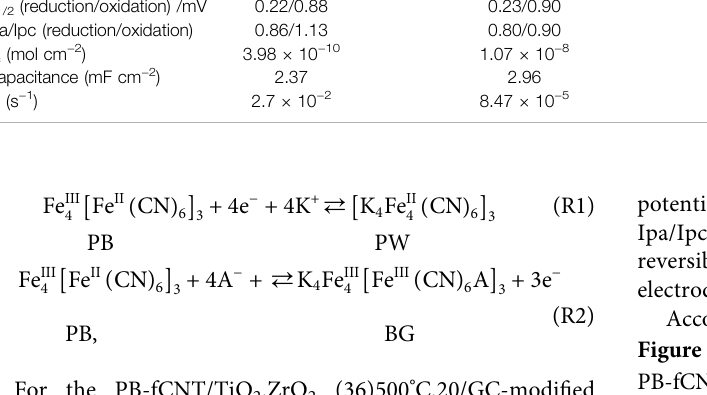
TABLE 4 | Comparison of the obtained electrochemical parameters for the PB-fCNT/TiO 2 .ZrO 2 (36)500 ° C.20/GC electrode with the prepared electrodes under the same conditions with the individual oxides in their structure (Li et al., 2007; Rathee et al., 2021).